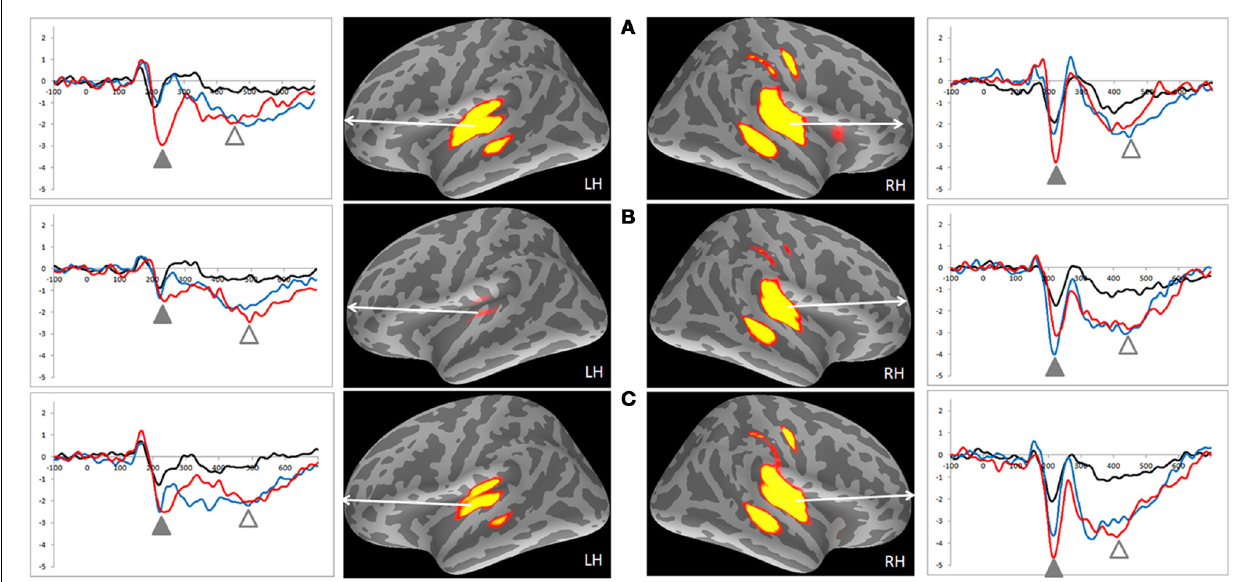
FIGURE 3 | MMNm-related cortical activities and source-specific (dSPM) time courses of ROIs in the emotional syllables and complex and simple tones. (A) Emotional syllables. (B) Complex tones. (C) Simple tones. Positive dSPM values indicate the current flowing outward from the cortical surface, whereas negative values indicate the current flowing inward. Grand average